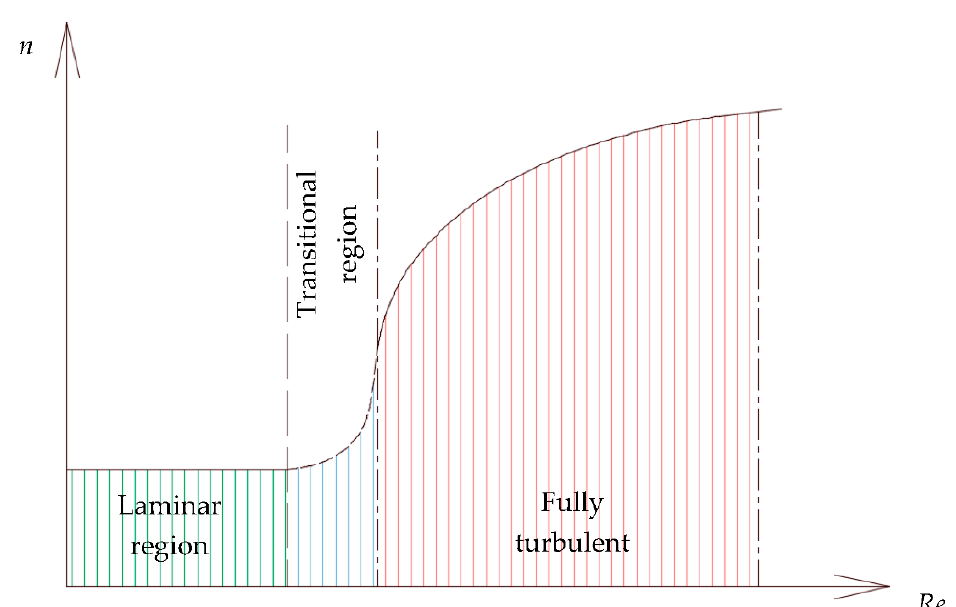
Figure 7. A schematic of the proposed variations of the exponent n over the whole spectrum of Re .